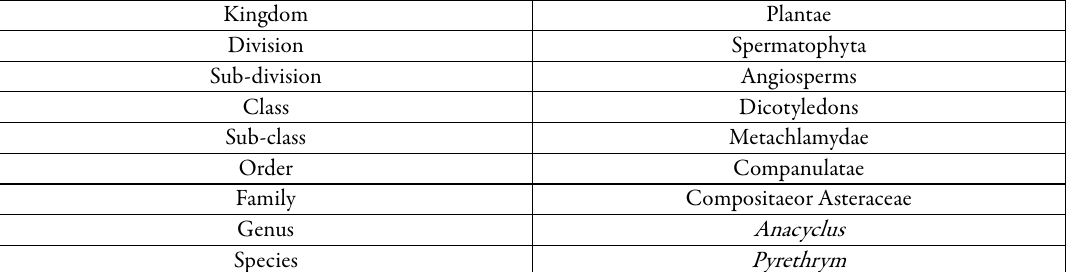
Table 1. Scientific classification of Anacyclus pyrethrum Kingdom Plantae